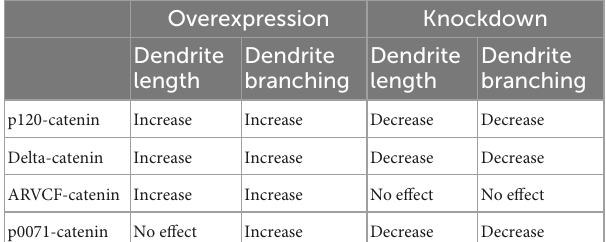
TABLE 1 Summary of p120-catenin subfamily expression effects on dendrite length and branching in rat primary hippocampal